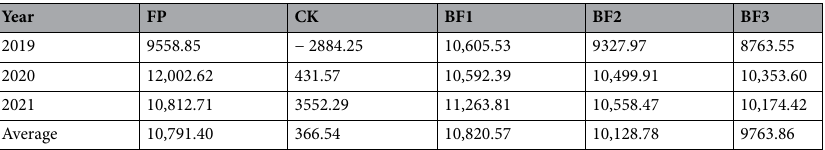
Table 5. Net income (RMB ha −1 ) of spring wheat production among different treatments. FP, CK and BF indicate farmer practice, control and balanced fertilization,